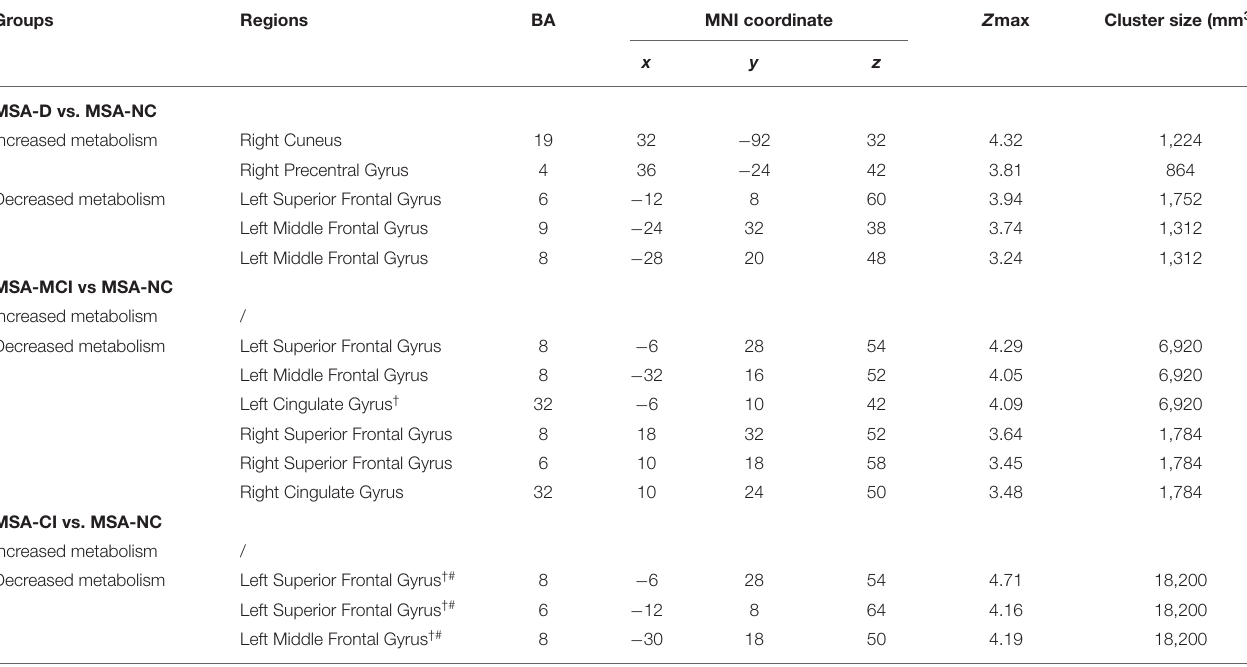
TABLE 3 | Brain regions with significant metabolic differences between three cognitive statuses of 84 MSA patients.